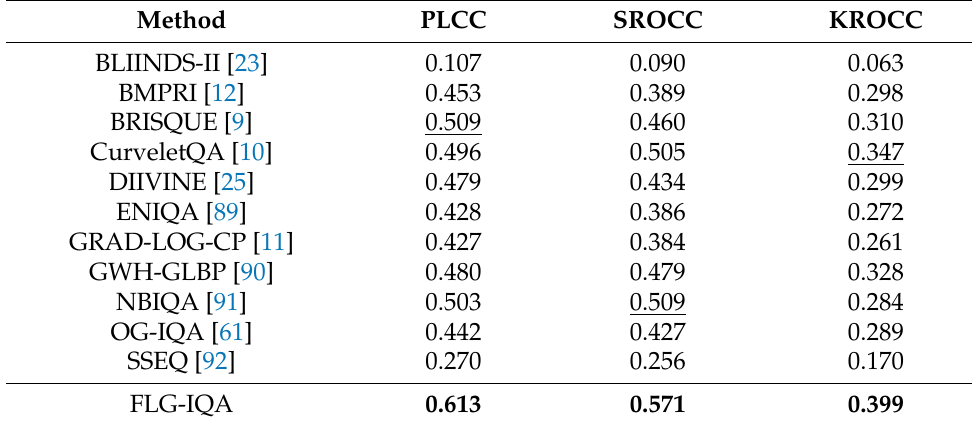
Table 11. Results of the cross-database test. The examined and the proposed methods were trained on KonIQ-10k [46] and tested on CLIVE [45]. The best results are in bold and the second-best results are